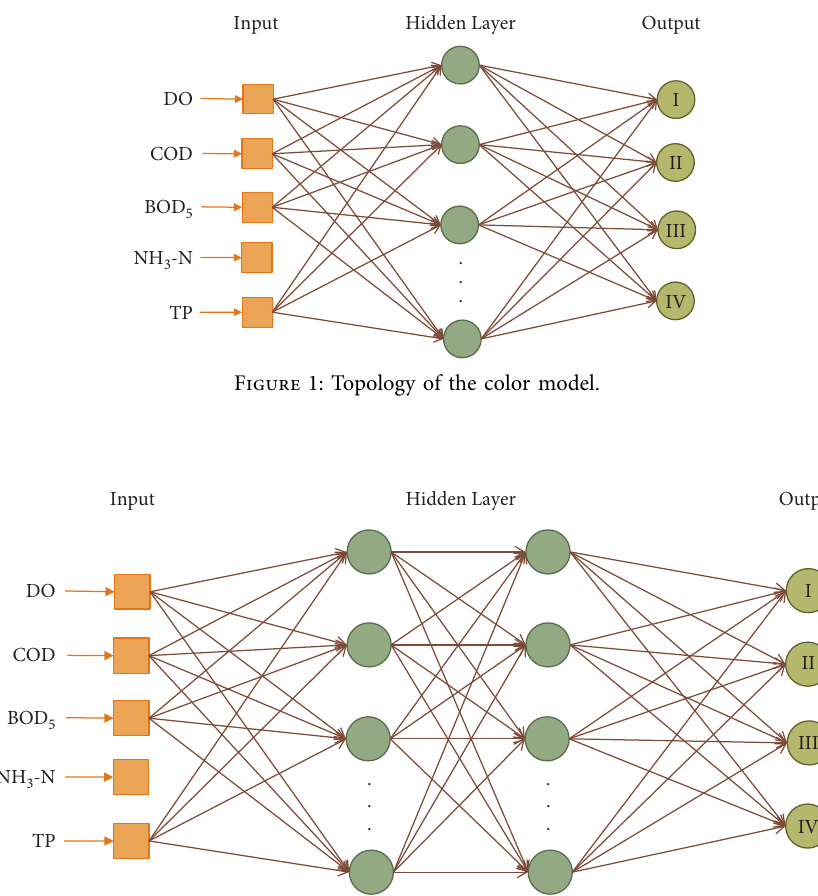
Figure 2: Topology of the odor